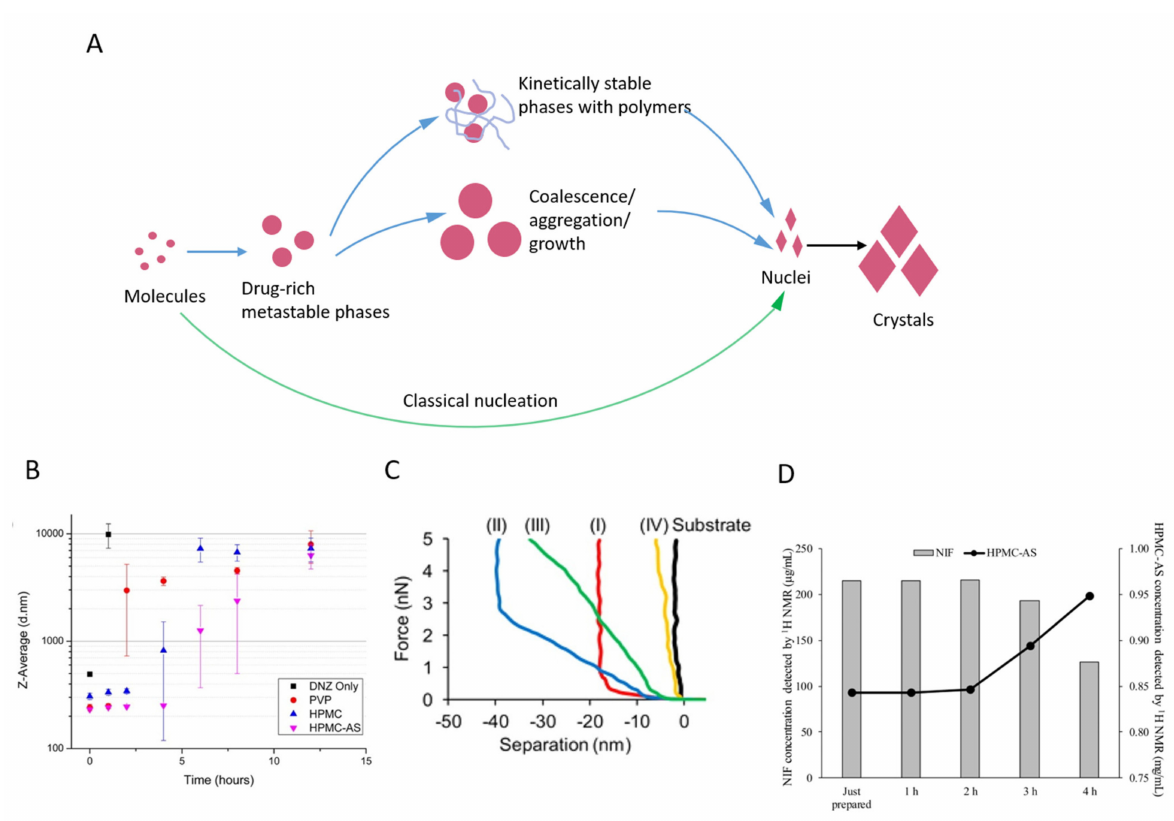
Figure 3. ( A ) Schematic illustration of the possible nucleation pathways (classical or non-classical) of drug in a solution. ( B ) Danazol Z—average diameters over time for systems with or without polymers. Reproduced with permission from [23], American Chemical Society, 2014. ( C ) Four schematic AFM force-distance curves for probucol (PBC)-HPMC-dodecyl sulfate systems over the storage time, (I) 1 d, (II) 2 d, (III) 4d, and (IV) 7d. Reproduced with permission from [106], American Chemical Society, 2015. ( D ) Solution 1H NMR detectable nifedipine and HPMCAS concentration over time. Reproduced with permission from [107], American Chemical Society,